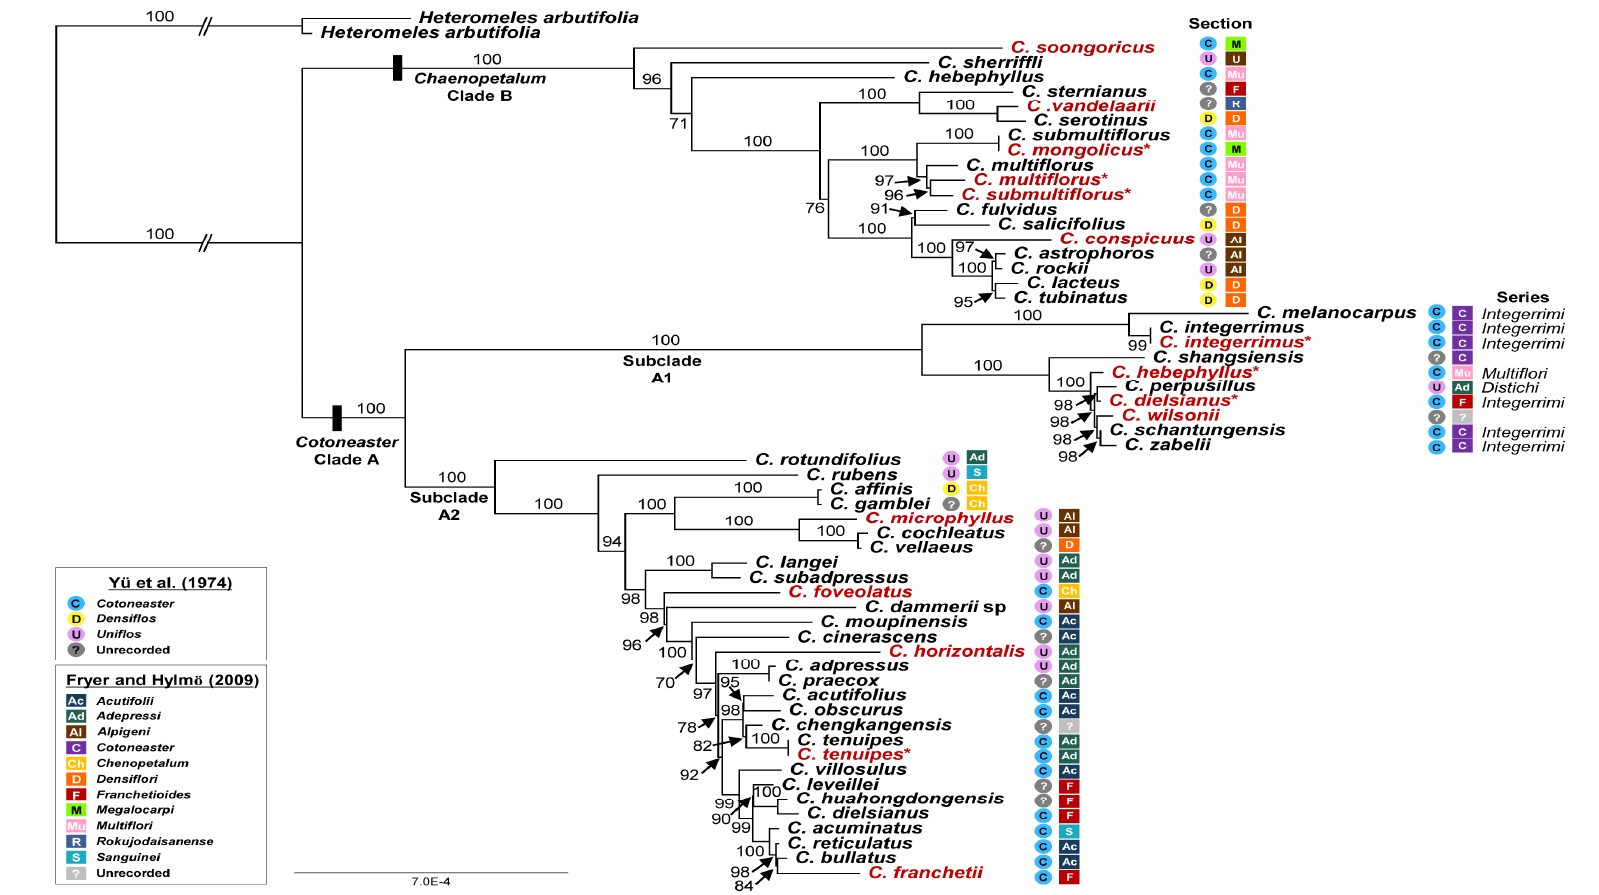
Figure 5. Maximum likelihood tree inferred from 57 species of Cotoneaster and two Heteromeles plastomes used as the outgroup. Bootstrap values based on 1000 replicates are shown on each node. Fifteen accessions included in the comparative analyses are shown in red and of these 15 accessions, seven newly sequenced accessions in the current study are indicated using asterisks [1,5].